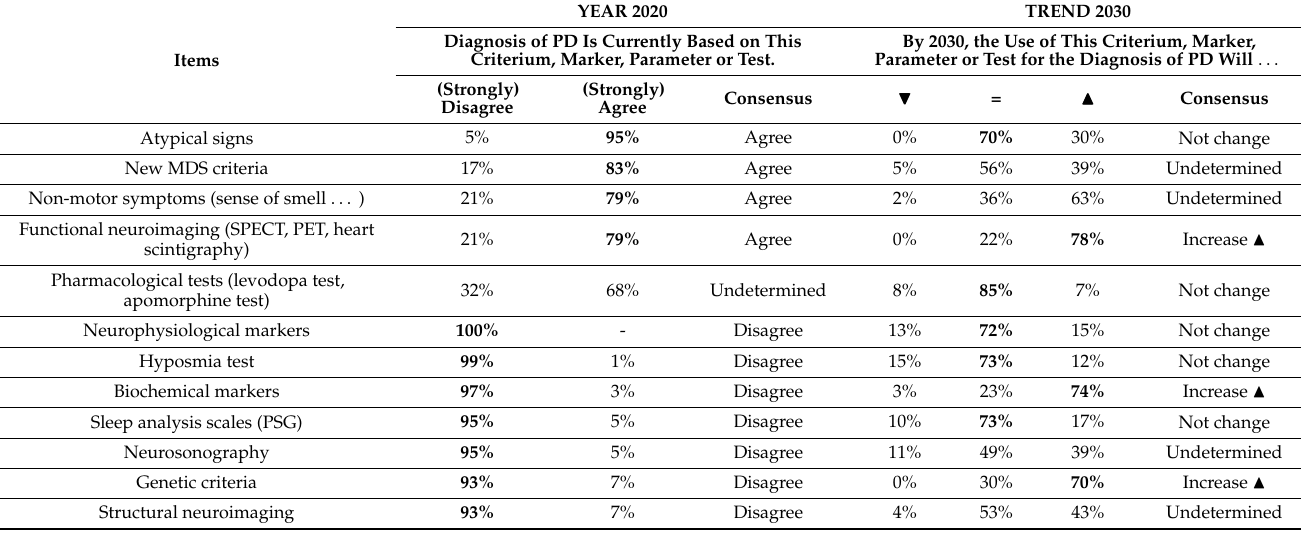
Table 2. Criteria, scales and/or tests for the diagnosis of PD: present and future (consensus after both rounds).